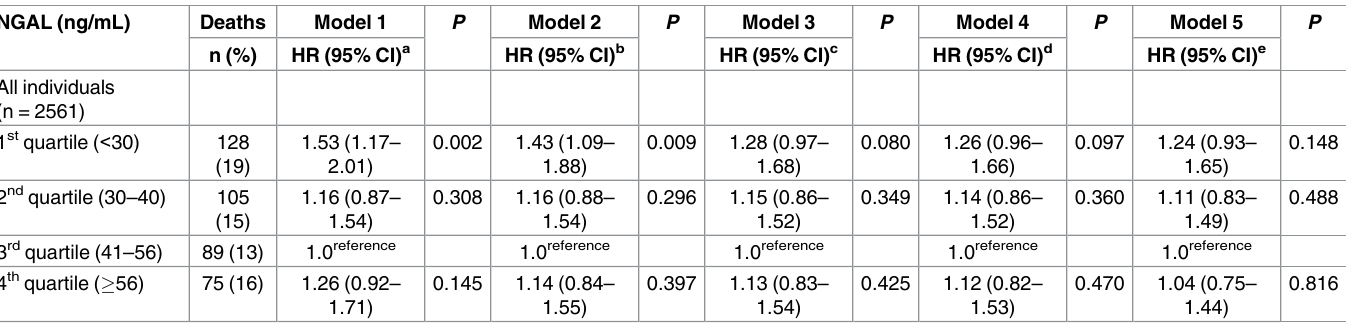
Table 6. Hazard ratios (HR) for death from cardiovascular causes according to NGAL (eGFR > 60 ml/min/1.73 m 2 ). NGAL